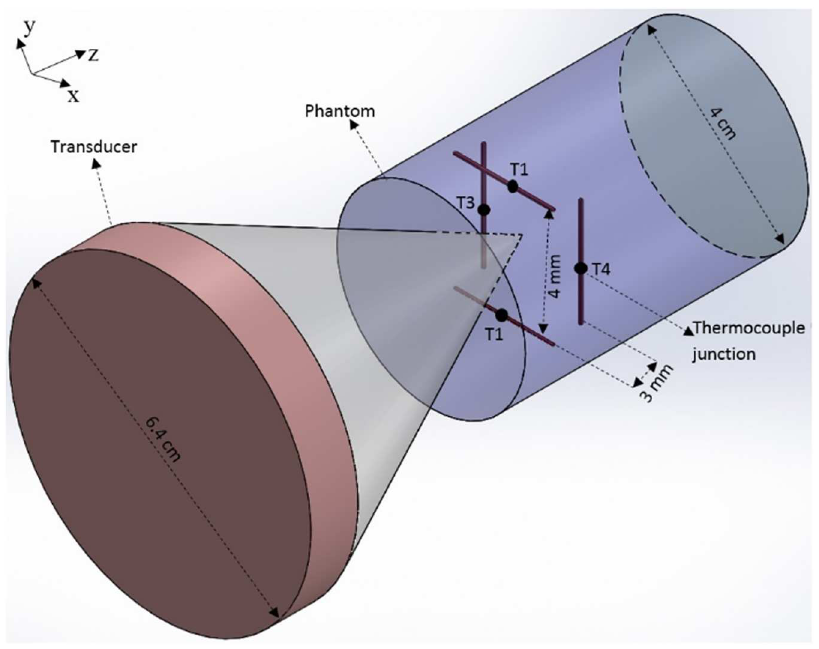
Fig 1. Schematic of the transducer and the phantom with four